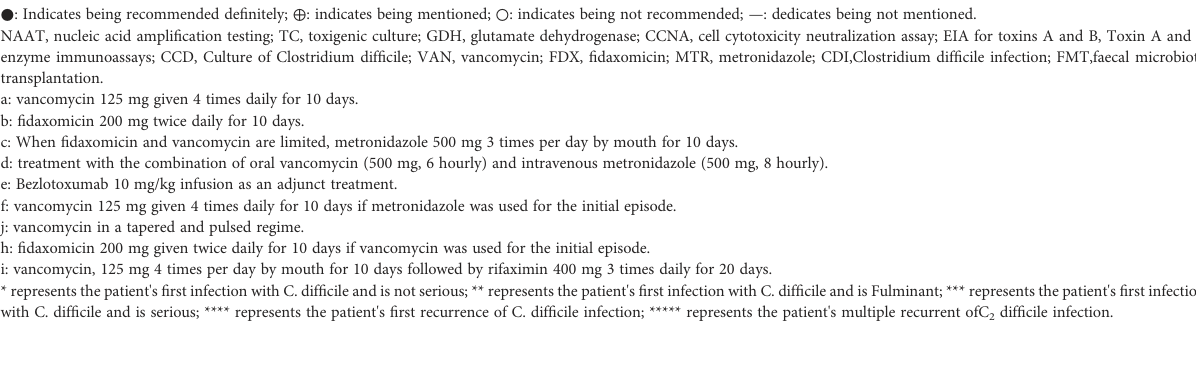
— — — ● — — ● ● ● ⊕ ○ ● : Indicates being recommended de fi nitely; ⊕ : indicates being mentioned; ○ : indicates being not recommended; — : dedicates being not mentioned. NAAT, nucleic acid ampli fi cation testing; TC, toxigenic culture; GDH, glutamate dehydrogenase; CCNA, cell cytotoxicity neutralization assay; EIA for toxins A and B, Toxin A and B enzyme immunoassays; CCD, Culture of Clostridium dif fi cile; VAN, vancomycin; FDX, fi daxomicin; MTR, metronidazole; CDI,Clostridium dif fi cile infection; FMT,faecal microbiota transplantation. a: vancomycin 125 mg given 4 times daily for 10 days. b: fi daxomicin 200 mg twice daily for 10 days. c: When fi daxomicin and vancomycin are limited, metronidazole 500 mg 3 times per day by mouth for 10 days. d: treatment with the combination of oral vancomycin (500 mg, 6 hourly) and intravenous metronidazole (500 mg, 8 hourly). e: Bezlotoxumab 10 mg/kg infusion as an adjunct treatment. f: vancomycin 125 mg given 4 times daily for 10 days if metronidazole was used for the initial episode. j: vancomycin in a tapered and pulsed regime. h: fi daxomicin 200 mg given twice daily for 10 days if vancomycin was used for the initial episode. i: vancomycin, 125 mg 4 times per day by mouth for 10 days followed by rifaximin 400 mg 3 times daily for 20 days. *representsthepatient's fi rstinfectionwithC.dif fi cileandisnotserious;**representsthepatient's fi rstinfectionwithC.dif fi cileandisFulminant;***representsthepatient's fi rstinfection with C. dif fi cile and is serious; **** represents the patient's fi rst recurrence of C. dif fi cile infection; ***** represents the patient's multiple recurrent ofC 2 dif fi cile